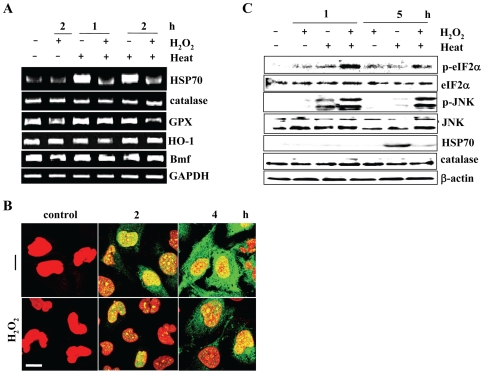
Effects of H2O2 on HSR and expression of scavenger enzymes.
A) Total RNA was harvested from T98G cells at the indicated hours after the indicated treatments (44°c for 20 min and/or 0.25 mM H2O2) and transcripts of the indicated genes were evaluated by RT-PCR. B) Confocal microscopical detection of HSP70. Cells were pretreated with 0.25 mM H2O2 (H2O2) or untreated (control) and fixed at 2 or 4 h after heat exposure. HSP70 expression was immuunohistochemically detected using the anti-HSP70 antibody and cells were counter-stained with propidium iodide (PI). Bar indicates 10 µm. C) eIF2α and JNK phosphorylation. At 1 and 5 h after indicated treatments as described above, eIF2α and JNK activities were evaluated by western blots using anti-phosphorylated eIF2α and anti-phosphorylated JNK antibodies, respectively. HSP70 and catalase expression levels were also evaluated. Anti-β-actin, anti-eIF2α and anti-JNK protein antibodies show equal loading of protein samples.